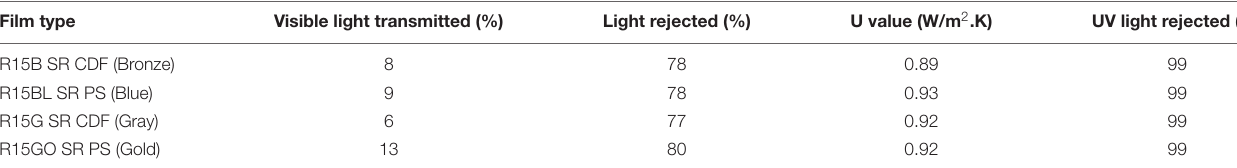
TABLE 3 | Window film products of the LLumar company (LLumar,